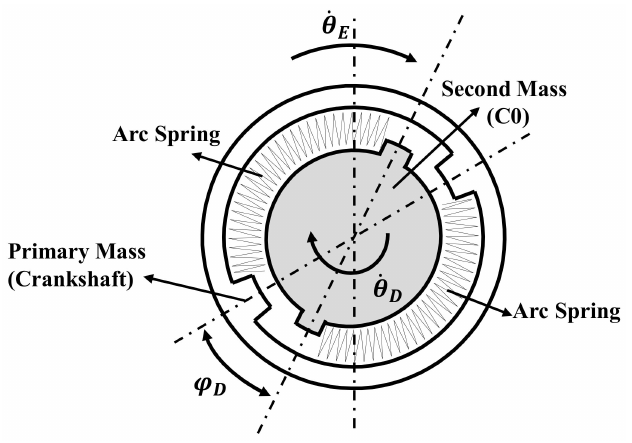
Figure 6. Simplified sketch of the DMF with compressed